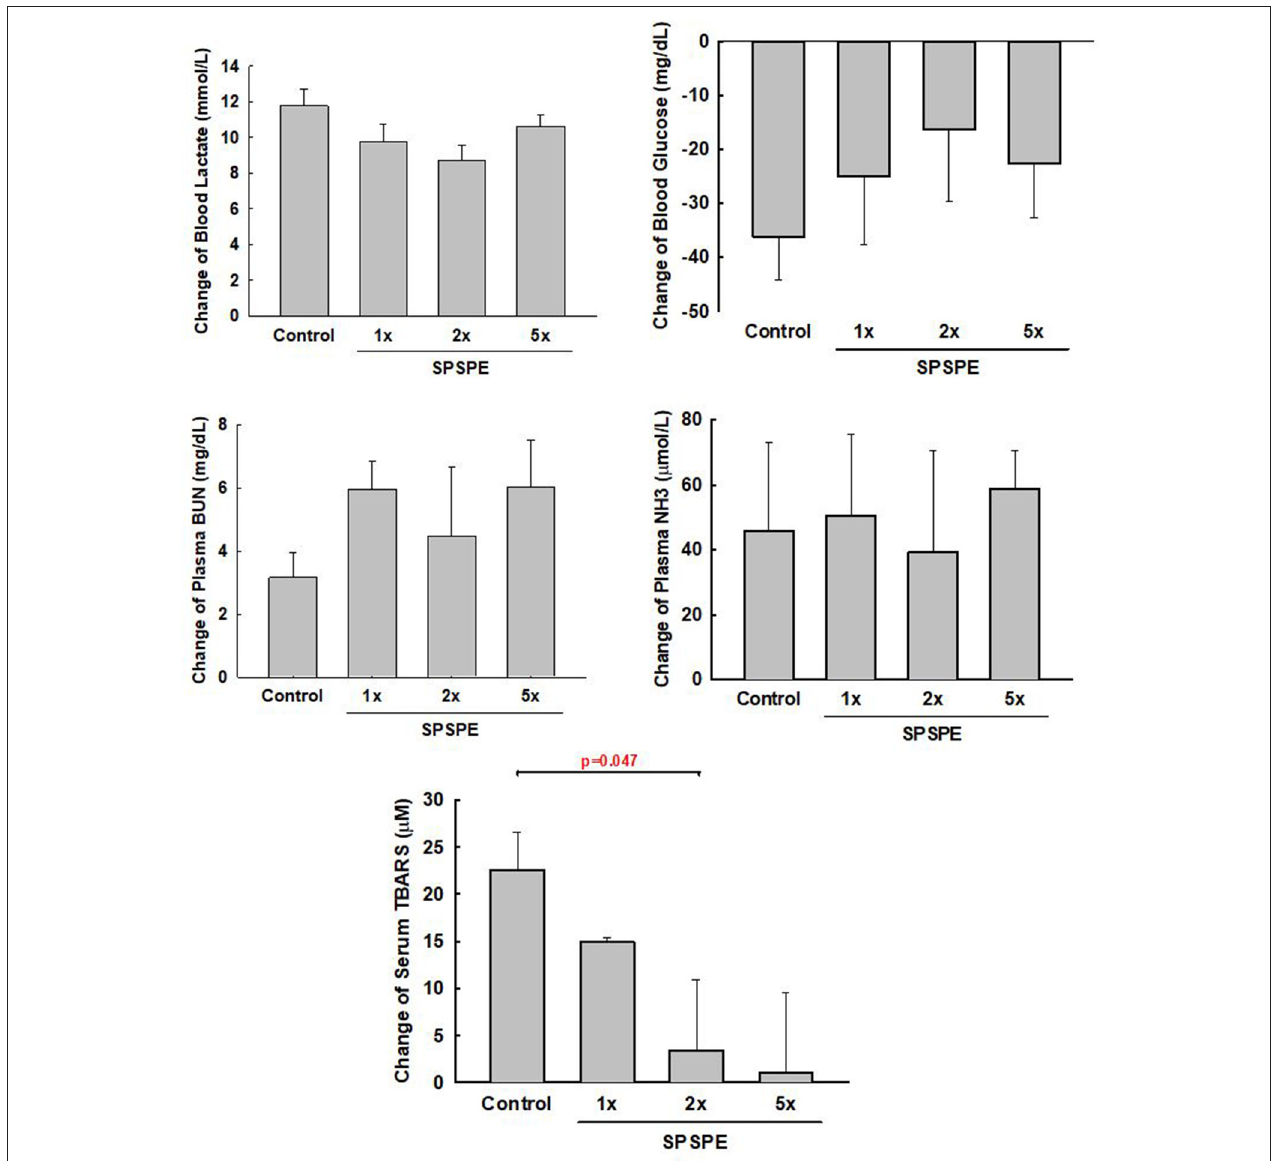
FIGURE 4 | The rats were administrated with different doses of SPSPE for 33 days. The change of circulating lactate, glucose, BUN, NH3, and TBARS after exhaustive swimming exercise test is shown each value represents Mean ± SEM, n = 9.